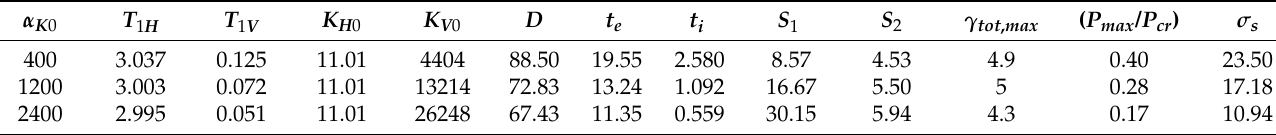
Table 7. Properties of HDRBs for the B10 test structure (dimensions in kN, cm and s). α K